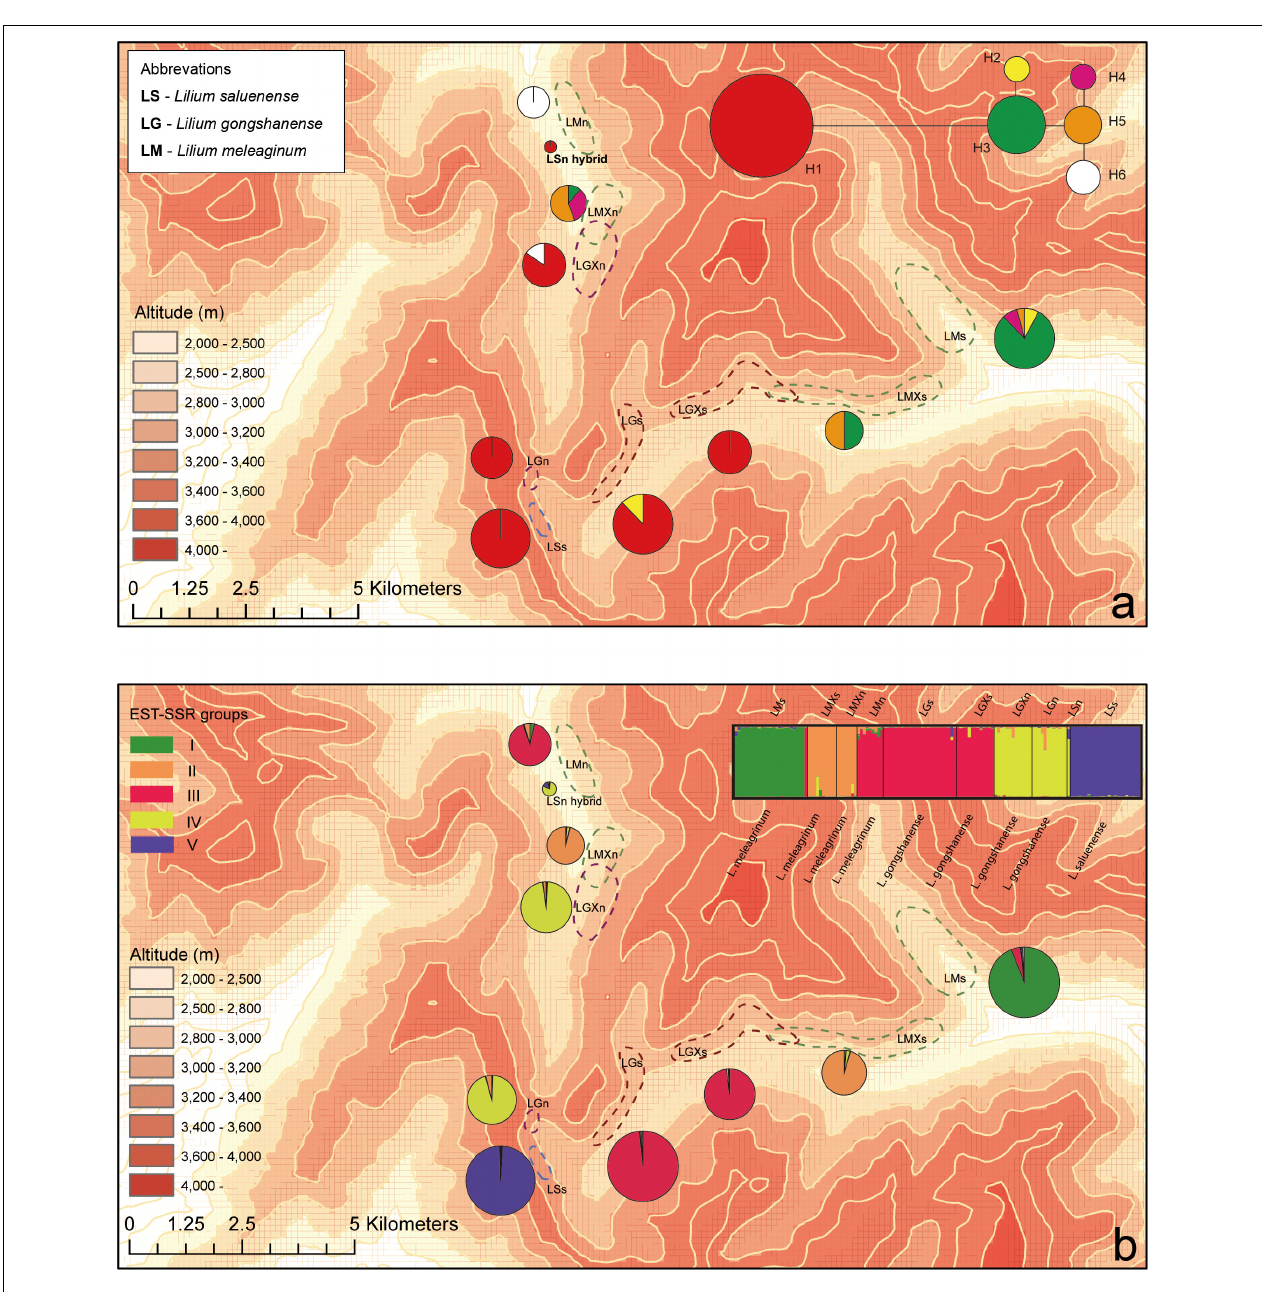
FIGURE 3 | Geographic distributions of genotypes among 10 populations based on chloroplast and nuclear DNA. (a) Geographic distribution of six cpDNA haplotypes (H1–H6) and network of cpDNA haplotypes constructed by TCS 1.21. Sizes of circles in network are proportional to observed frequencies of haplotypes. (b) Geographic distribution of genotypes based on EST-SSR loci. Histogram of the STRUCTURE assignment test for the populations (139 individuals) shown at top. LM, Lilium meleagrinum ; LG, L. gongshanensis ; LS, L. saluenense . Map generated in ESRI ArcGIS 10.0 (ESRI, 2010).